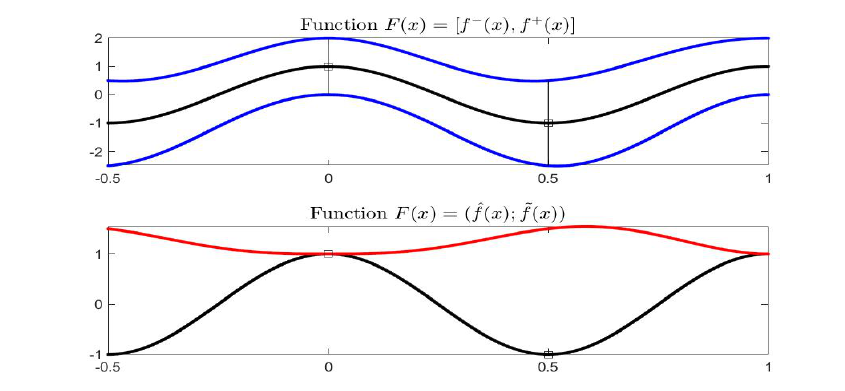
Figure 4. Interval ( top ) and midpoint ( bottom ) representations of function F ( x ) in Example 2.